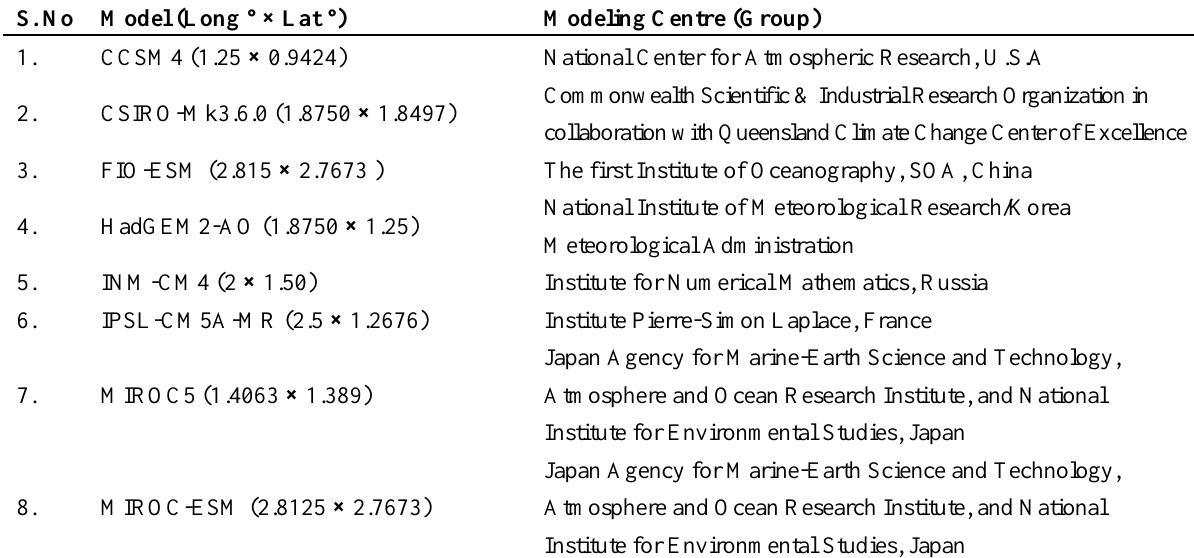
Table 1. Details of the CMIP5 models